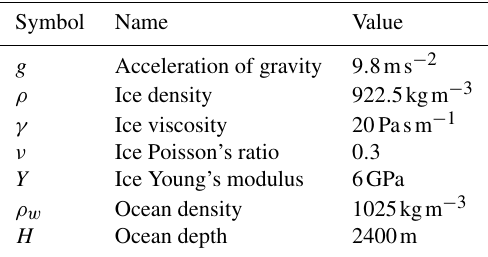
Table 1. Fixed model parameters and their